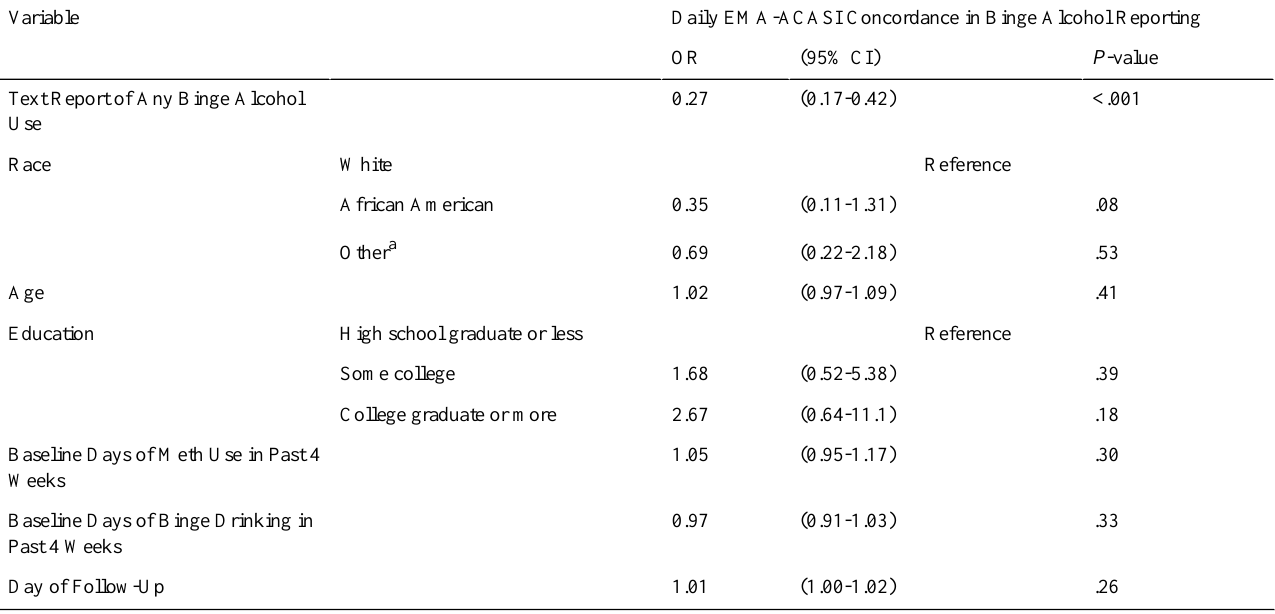
Table 5. Multivariable logistic regression model, fit with generalized estimating equations, assessing daily EMA-ACASI concordance in binge alcohol reporting (with text report of any binge alcohol use predictor) (n=981).